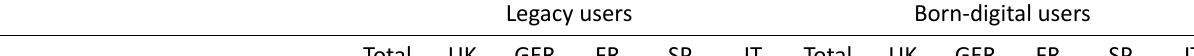
Table 5. Frequency distributions for media use, payment and media trust variables, 2015 (%). Legacy